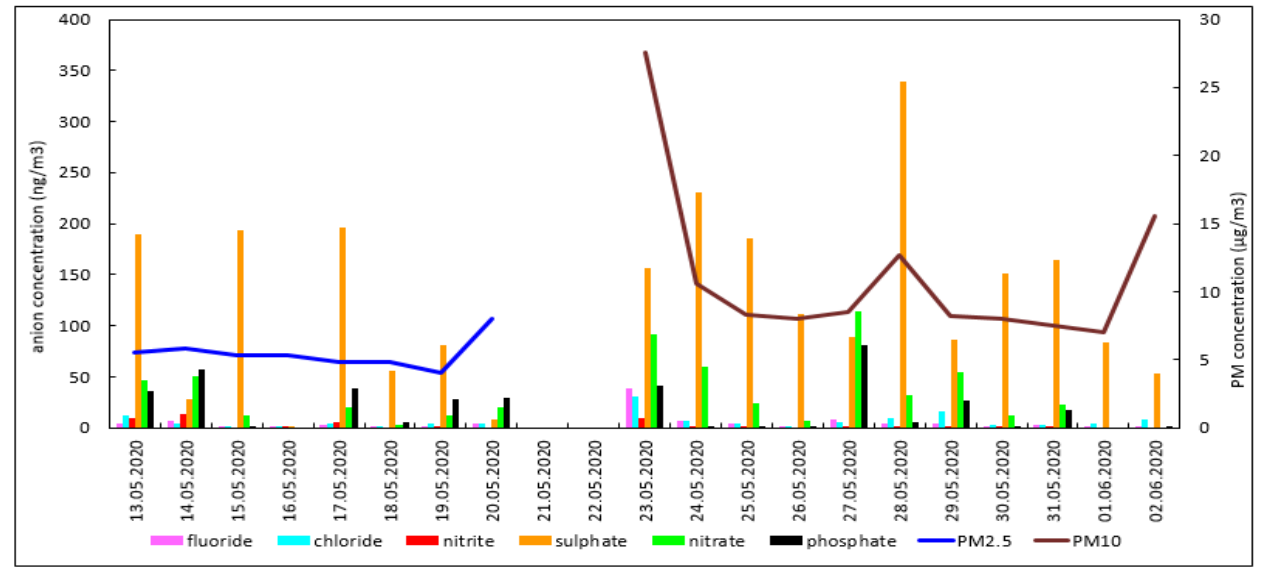
Figure 1. Mass concentration of PM 2.5 and PM 10 aerosols and concentration of anions in PM in cave with the speleotherapy facility in the Sloupsko-Sosuvsky Cave System. Figure interpretation. X -axis: Date of PM sample collection. Vertical bars correspond to the daily mean concentration of anions; Blue (Brown) line indicates the mean mass concentration of PM 2.5 (PM 10 ) aerosols.